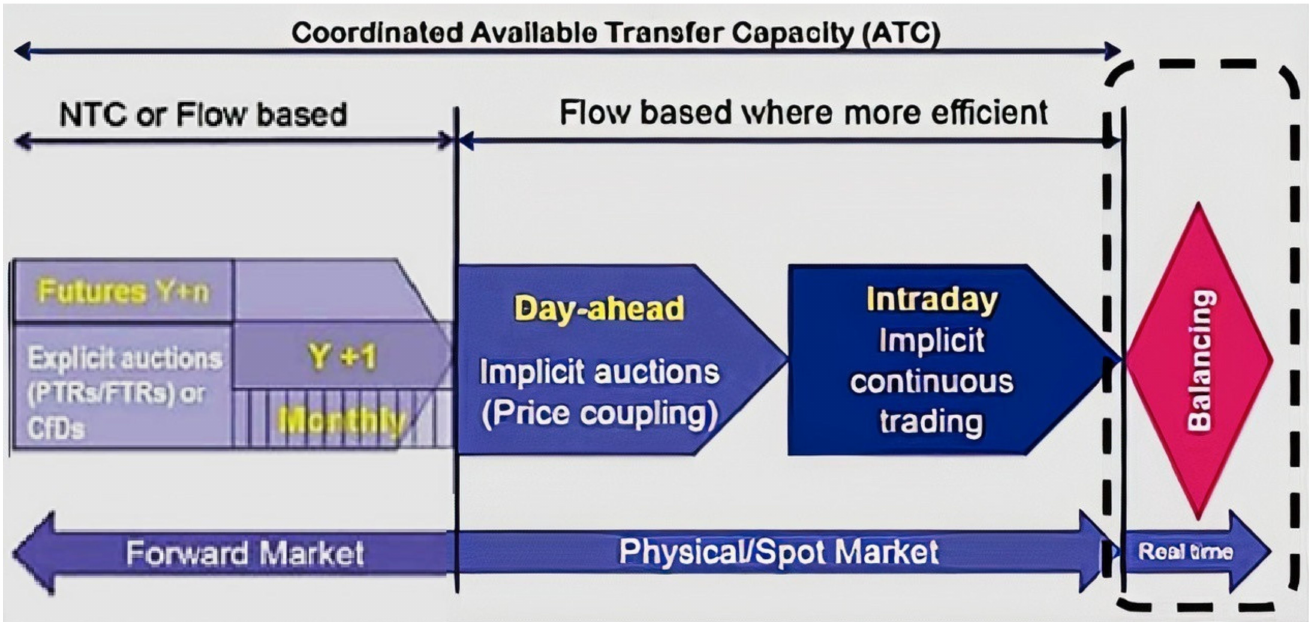
Figure 1. The different markets in the European electricity market